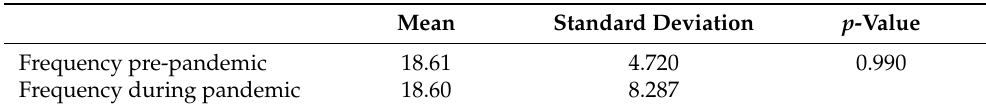
Table 5. Analysis of change of transfusion attendance before and during